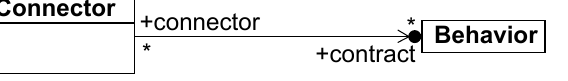
Figure 2. Abstract syntax in UML showing the contract